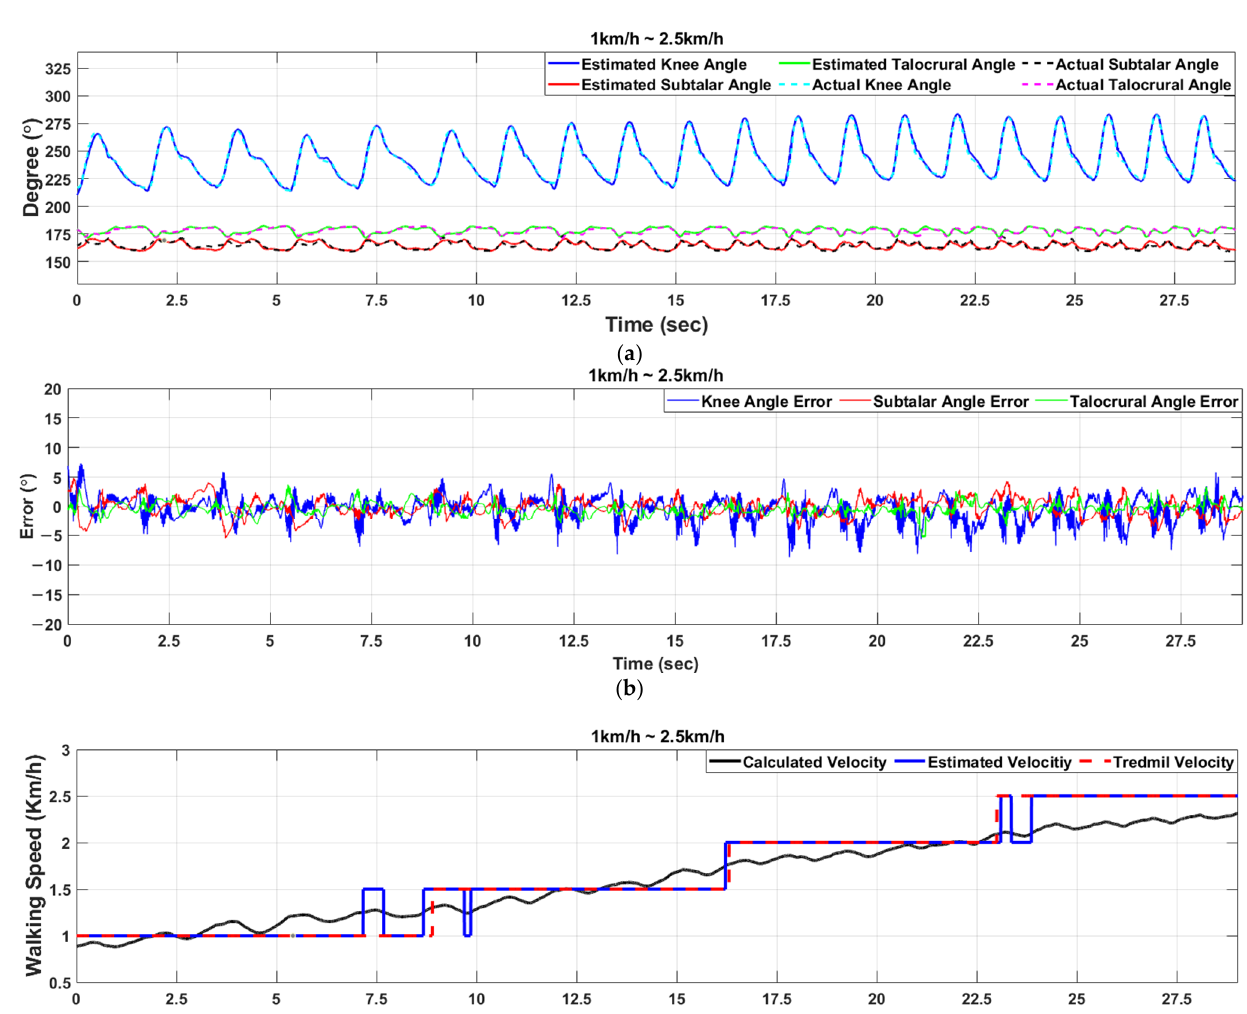
Figure 9. Experimental results for the estimation of knee and ankle angle during walking speed increases: ( a ) Results of estimating the angle of knee and ankle; ( b ) Results of the angle estimation error; ( c ) The result of walking speed estimation. Table 10. Percent error (PE) of angle estimation simulation according to walking